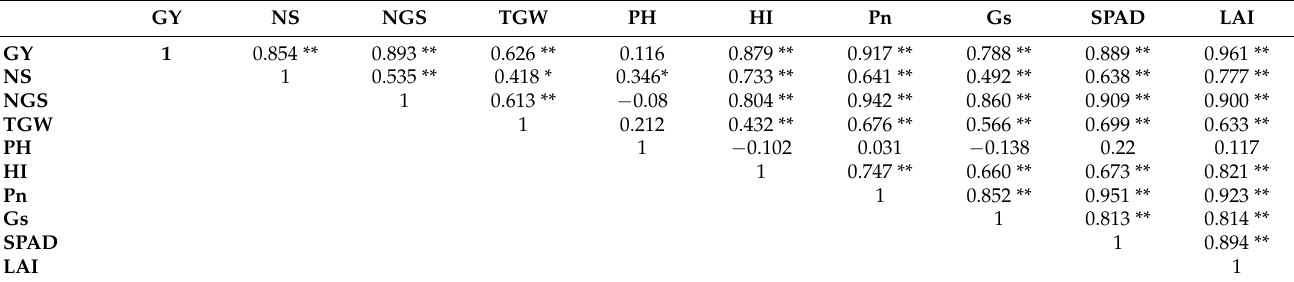
Table 7. Correlation analysis of grain yield with agronomic and photosynthesis traits.